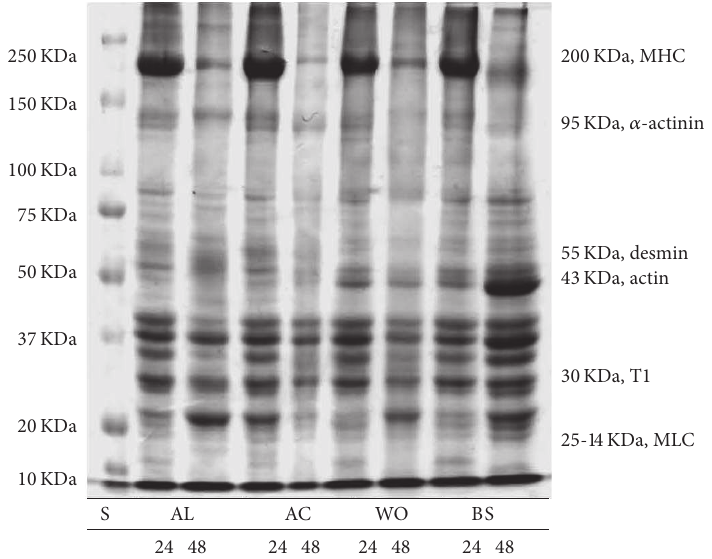
Figure 3: SDS-PAGE electrophoresis of marinated sheep. S: standard; AL24: test sample after 24h alkaline marinating; AL48: test sample after 48 h alkaline marinating; AC24: test sample after 24 h acid marinating; AC48: test sample after 48 h acid marinating; WO24: test sample after 24 h water-oil marinating; WO48: test sample after 48 h water-oil marinating; BS24: test sample after 24 h brine soaking; BS48: test sample after 48 h brine soaking.